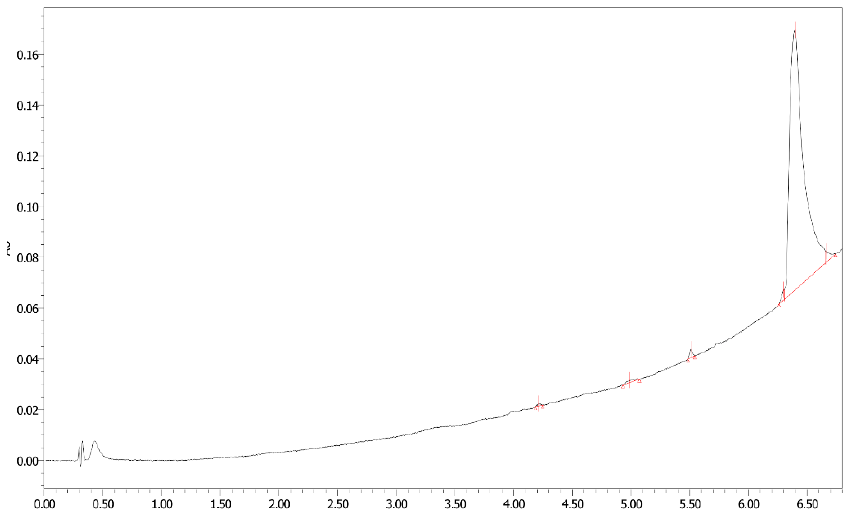
Figure 1. UPLC chromatograms highlighting the purification of PBL by dialysis. Matrix-assisted laser desorption/ionization-time of flight mass spectrometry (MALDI- TOF-MS) spectra were obtained using an AXIMA ® Confidence system (Shimadzu Corp., Kyoto, Japan). The matrix involved α -cyano-4-hydroxycinnamic acid that was dissolved into water containing 0.1% TFA/acetonitrile (1:1). The samples were mixed with the matrix solution in a volume ratio of 1:1 with a final concentration of 0.5 mg/mL. The PBL exact mass was 3146, and a peak of m/z 3147 M + H + was observed (Figure 2a). These spectra indicated a difference of 44 in adjacent peaks, corresponding to one unit (-CH 2 CH 2 O-) of PEG (Figure